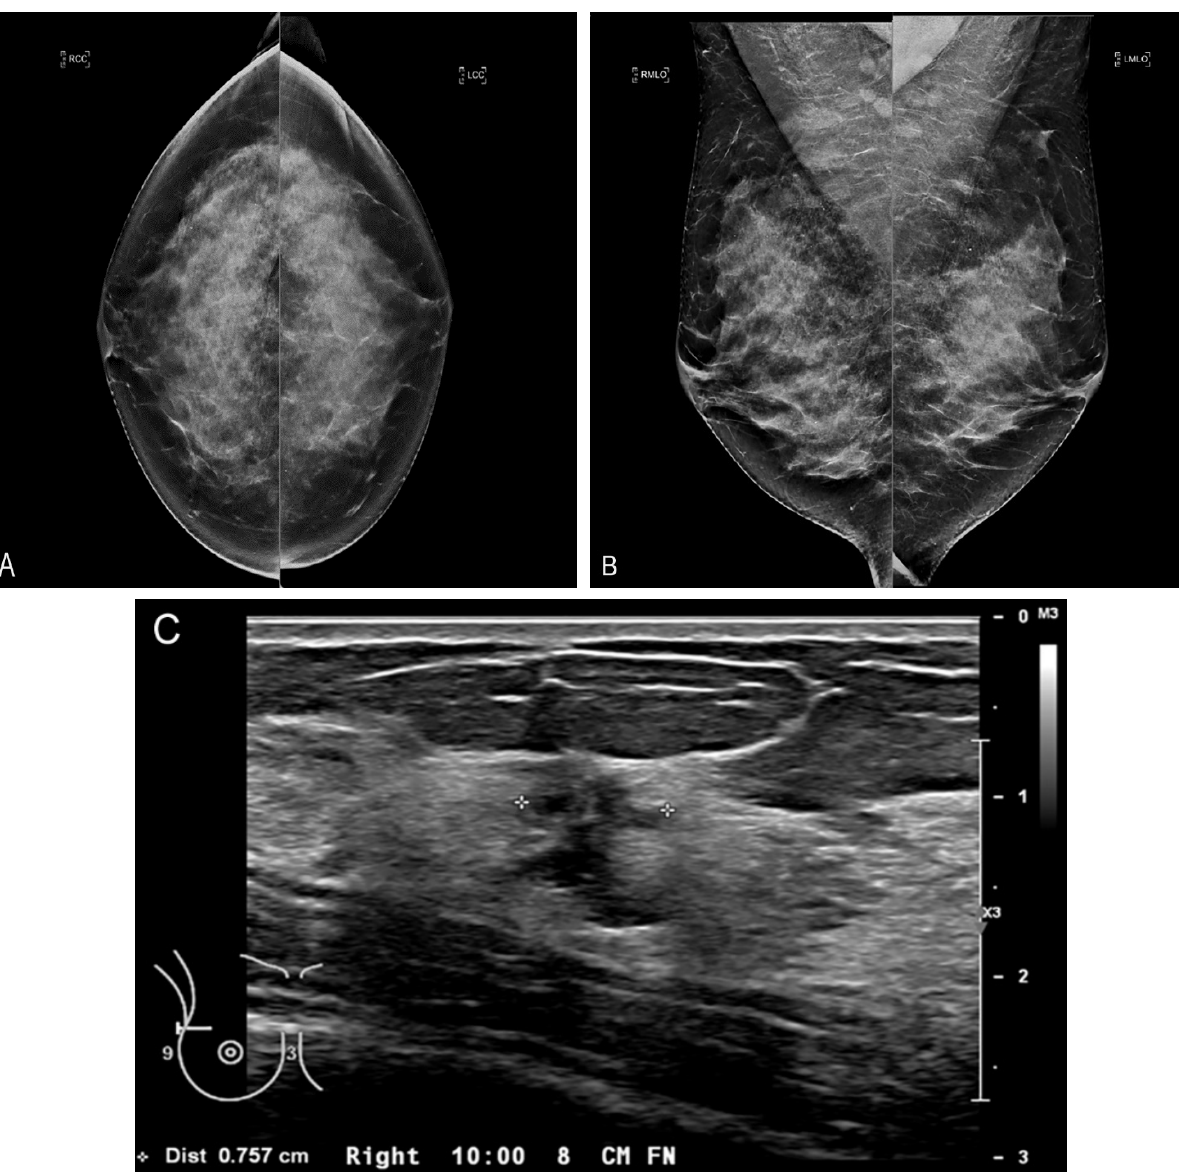
Figure 1. Limitation of mammography for dense breasts. Bilateral craniocaudal (CC) ( A ) and bilateral mediolateral oblique (MLO) ( B ) mammograms showing extremely dense breasts (ACR density category d) [7]. The mammogram is negative (Breast Imaging Reporting and Data System (BI-RADS) 1). ( C ) Fortunately, the patient had a screening ultrasound shortly thereafter showing a 1 cm cancer at the 10 o’clock position in the right breast. The mammogram was a false negative. The patient came to no harm since the ultrasound was performed within a short period of time. The cancer was grade I invasive ductal carcinoma with negative nodes. Survival after treatment is near 100% [8].